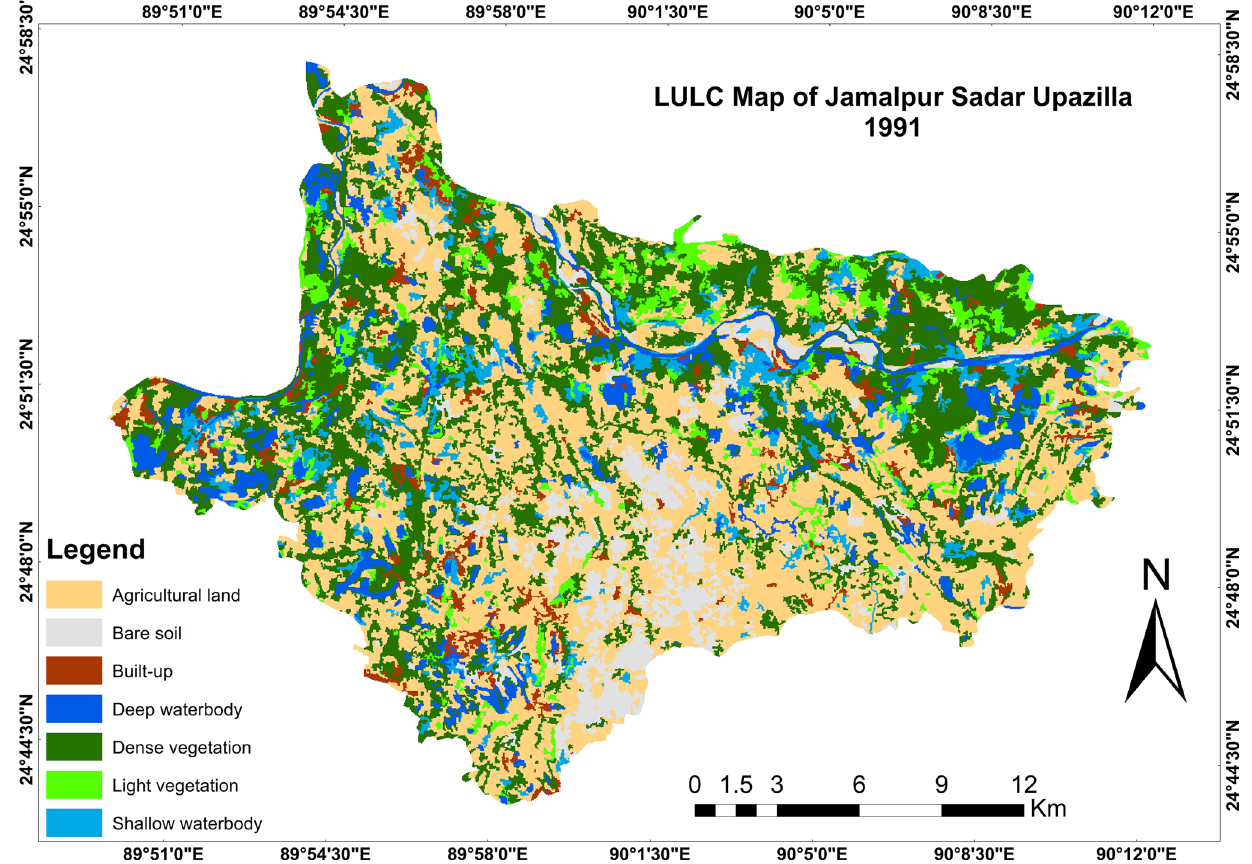
Fig. 3 Land use and land cover map of Jamalpur Sadar Upazila for the year